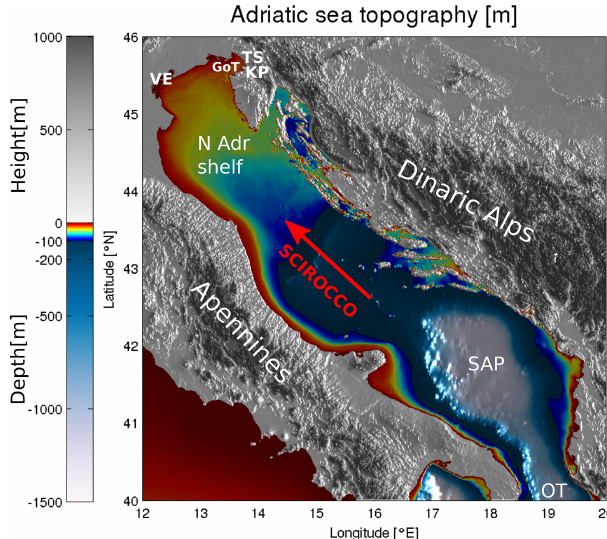
Figure 1. Adriatic orography and bathymetry. The following abbreviations are used: TS – Trieste, KP – Koper, GoT – Gulf of Trieste, VE – Venice, N Adr Shelf – northern Adri- atic Shelf, SAP – Southern Adriatic Pit, OT – Otranto Strait. Direction of Scirocco is marked with a red arrow. The im- age was created by the authors based on EMODnet bathymetry data, available at https://portal.emodnet-bathymetry.eu/ (last access: 27 October 2020), and the Copernicus European Digital Eleva- tion Model, available at https://land.copernicus.eu/imagery-in-situ/ eu-dem/eu-dem-v1-0-and-derived-products/eu-dem-v1.0 (last ac- cess: 27 October